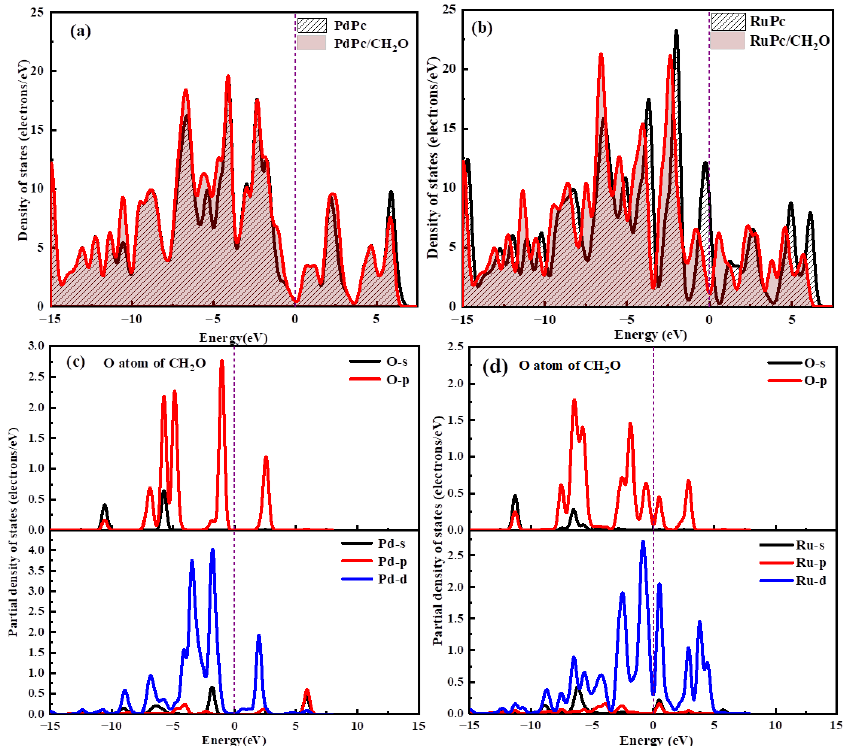
Figure 6. The density of states (DOSs) and partial density of states (PDOSs) of CH 2 O@PdPc and CH 2 O@RuPc adsorption systems. ( a,b ) DOSs map before and after CH 2 O adsorption on PdPc and RuPc, and ( c,d ) PDOSs of O, Pd, and Ru atoms. The Fermi level is set to zero energy and indicated by the purple dashed line.